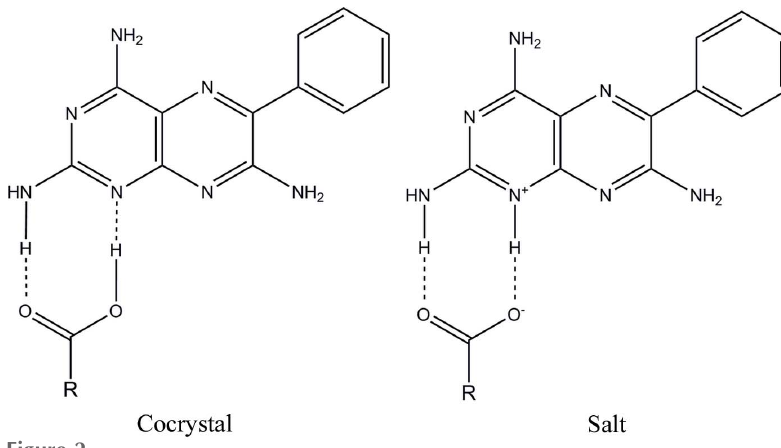
Figure 2 Proposed supramolecular heterosynthons between 1 and the acid